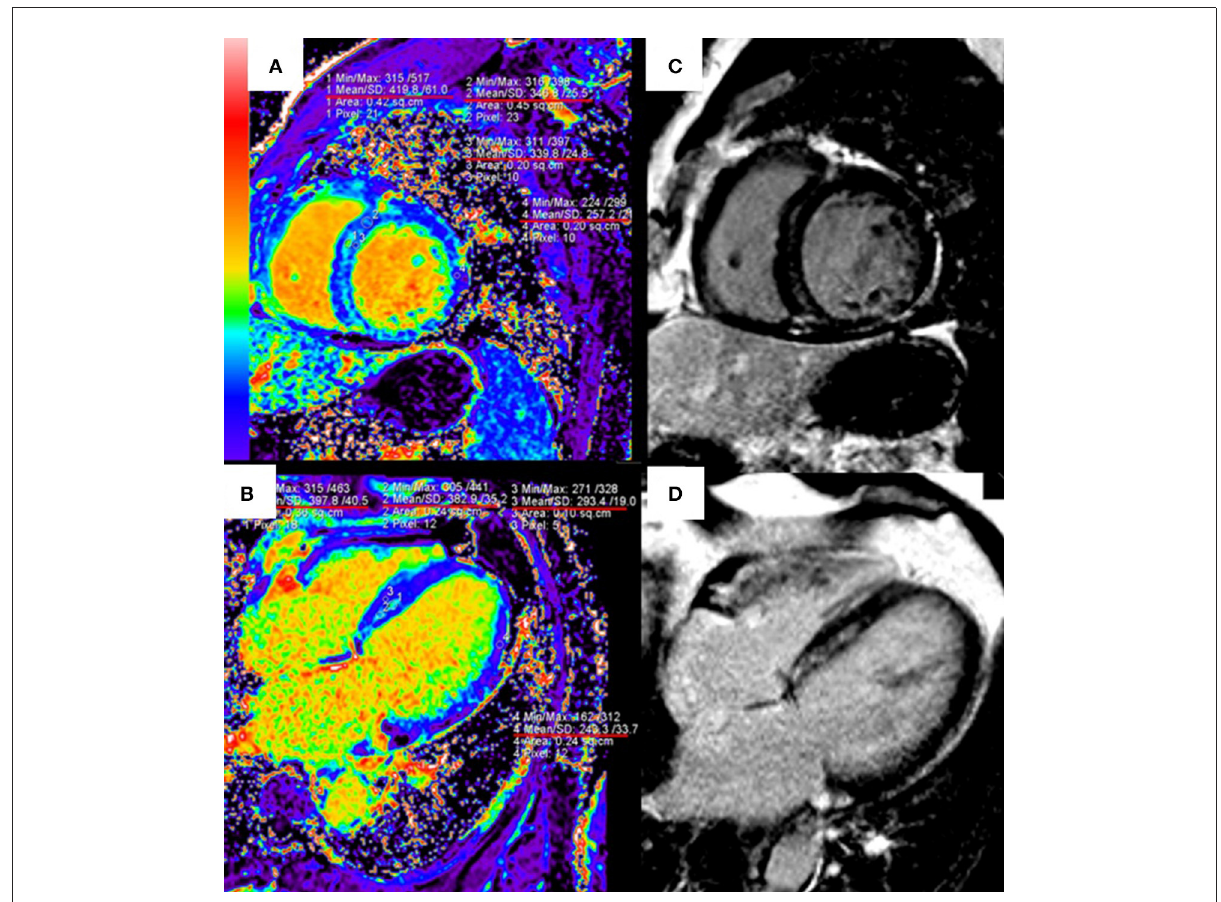
FIGURE2 Quantitative extracellular volume (ECV) fraction images [left column, (A,B) ] and late gadolinium enhancement (LGE) [right column, (C,D) ] in a hypertension patient. The abnormal ECV region is larger than LGE. Reprinted with permission from Wang et al.